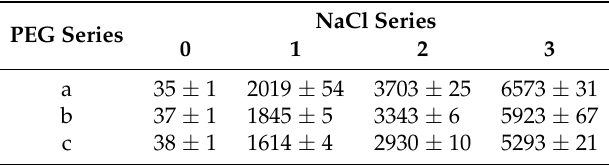
Table 10. Conductivities of all samples ( µ S/cm) at 21 ◦ C. Mean values calculated from 3 measurements are given along with standard deviations of the mean.